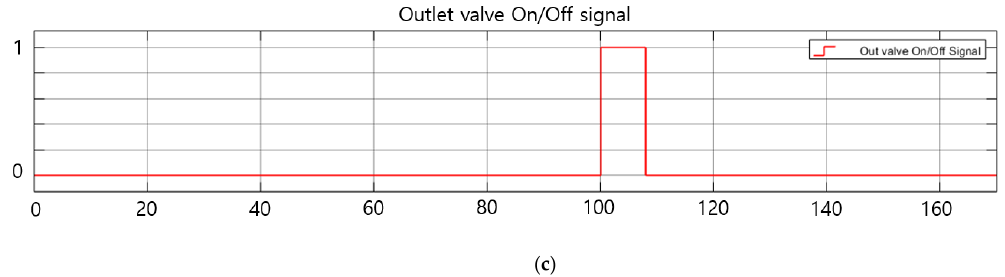
Figure 7. Storage tank dynamics with on/off valve signal: ( a ) inlet valve on/off signal of storage tank; ( b ) storage tank level simulation according to changing valve signals; ( c ) outlet valve on/off signal of storage tank.